Question: Condense the content of this figure into a single sentence.
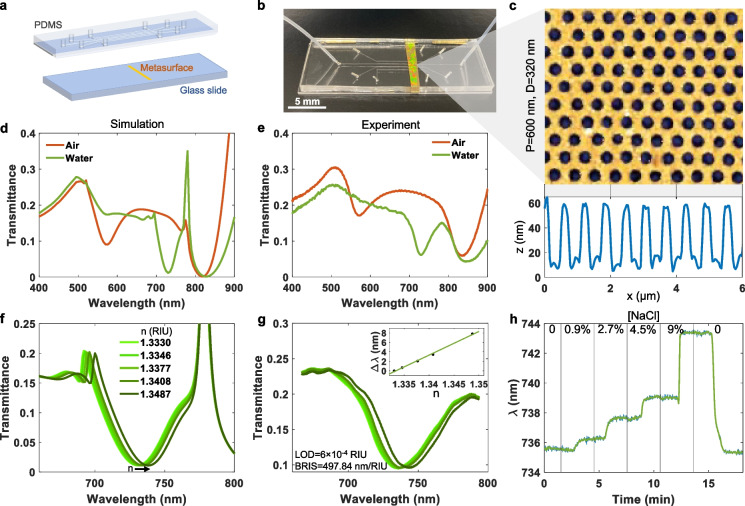
Answer: a Schematic of the microfluidic integration on AuNHA metasurface. b Optical photograph of the integrated optofluidic meta-sensor. c Zoom-in of the AuNHA metasurface: atomic force microscopy image with a representative line profile shown at the same scale. d Simulated transmission spectra and e Experimentally measured spectra in both air and water. f Simulated spectral shifts and g Experimental measured spectral shifts as the solution RI gradually increases from 1.3330 to 1.3487. h Real-time sensorgram recording the centroid wavelength as the overflowing NaCl solution concentration changes stepwise